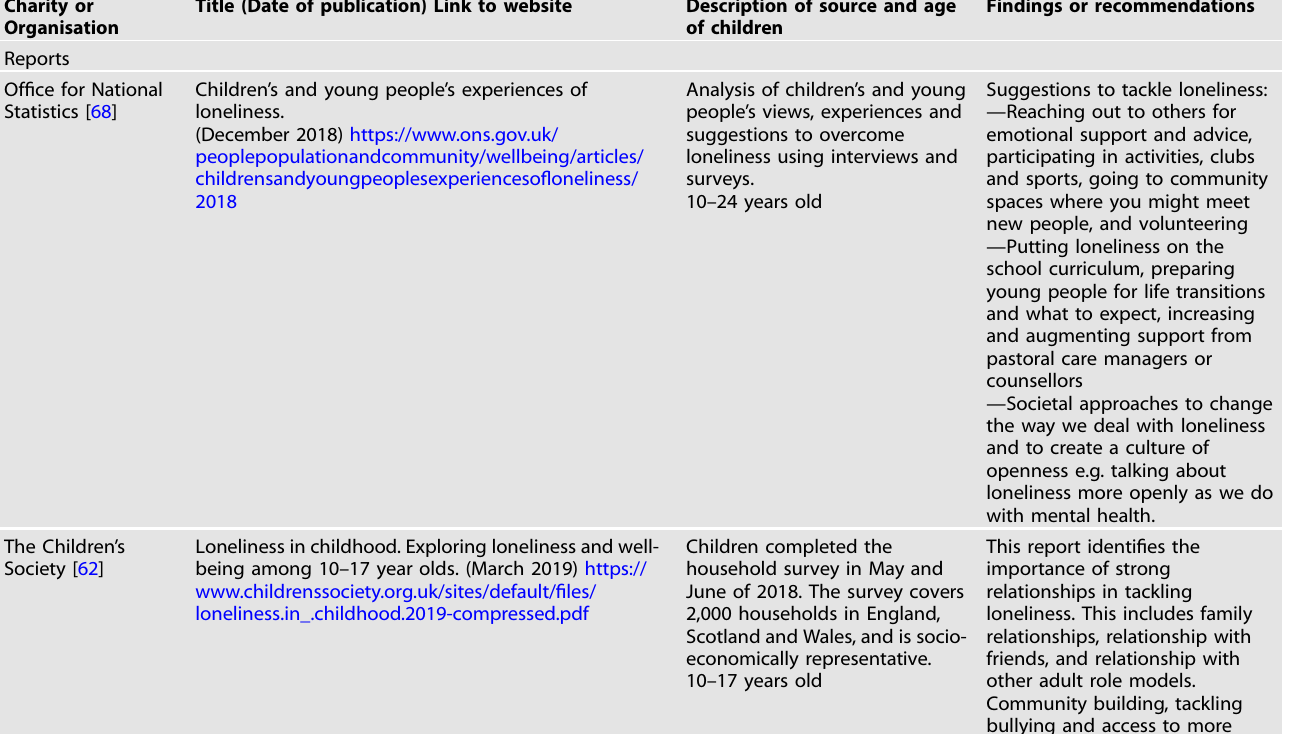
Table 3. Included third sector and policy evidence from 25 sources (reports, websites, projects and resources). Charity or